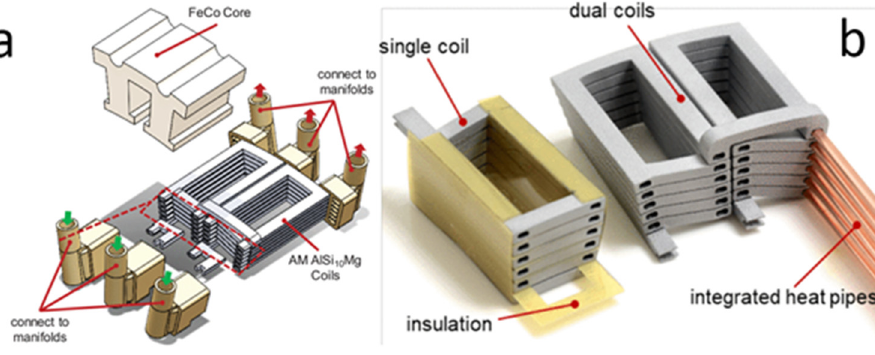
Figure 18. AM ( a ) hollow windings [4] and ( b ) with integrated copper heat pipes reprinted with permission from Ref. [97]. Copyright 2021 Elsevier. Table 2. Comparison of different AM direct conductor cooling